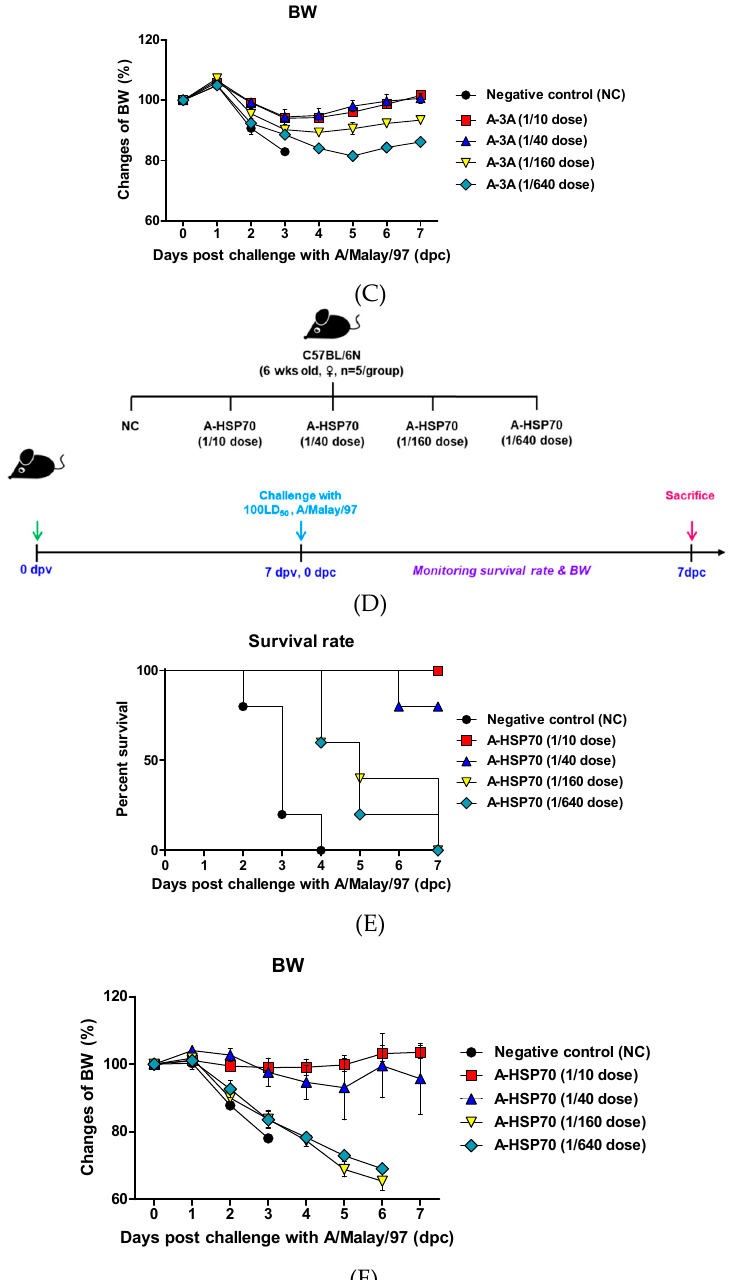
Figure 2. A-3A- and A-HSP70-mediated vaccine efficacy and protective effects in mice. ( A - F ) represent: ( A – C ) A-3A; ( D – F ) A-HSP70. C57BL/6 mice were administered the test vaccine at 1/10, 1/40,